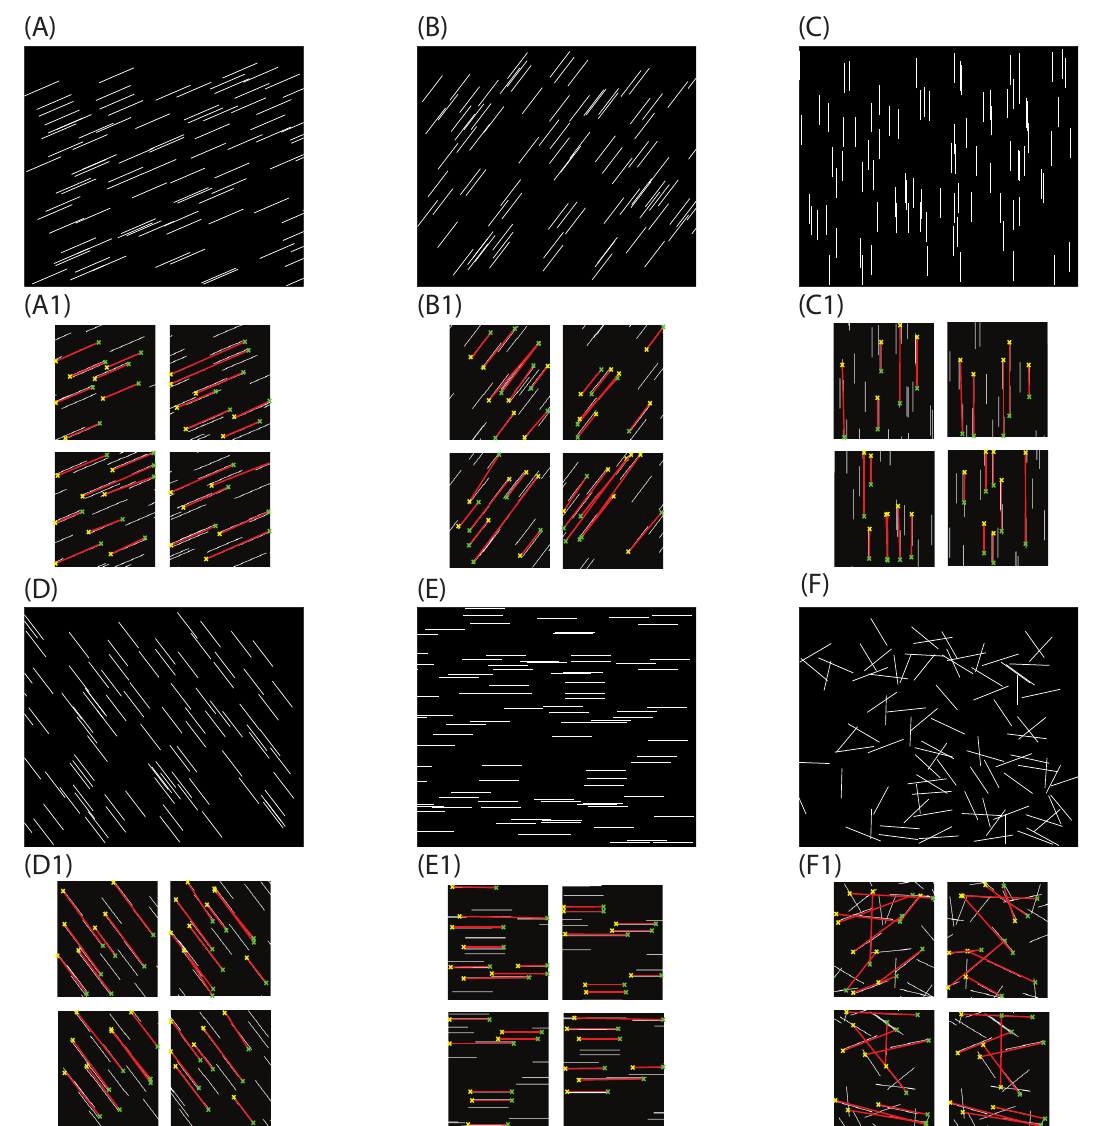
Figure 5. Artificially created actin cytoskeleton images with the F-actin alignment angles of: ( A ) 30 ◦ ; ( B ) 60 ◦ ; ( C ) 90 ◦ ; ( D ) 120 ◦ ; ( E ) 180 ◦ ; and ( F ) random with a standard deviation of 52.75 ◦ . PAD and TAD of models ( A – E ) are all 0 ◦ , and 52.75 ◦ for model (F); ( A1 – F1 ) are the line detection results of the four selected segments of the models ( A – F ),